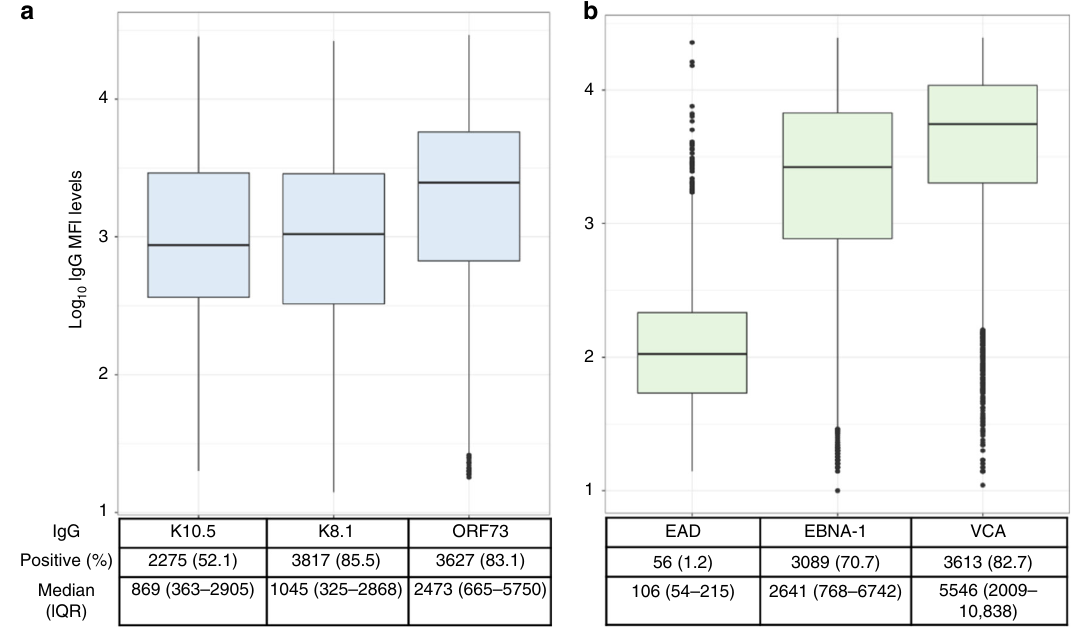
Fig. 1 Inter-individual variability in IgG antibody responses to KSHV and EBV ( n = 4365 individuals). a Distribution of anti-KSHV antibody levels (Log 10 MFI) for K10.5 (min = 0, max = 28,514), K8.1 (min = 0, max = 26,468) and ORF73 (min = 0, max = 29,308). b Distribution of anti-EBV antibody levels (Log 10 MFI) for EAD (min = 0, max = 22,747), EBNA-1 (min = 0, max = 24,696), VCA (min = 11, max = 24,754). Seropositivity to all antigens and median (centre) plus IQR displayed in the text